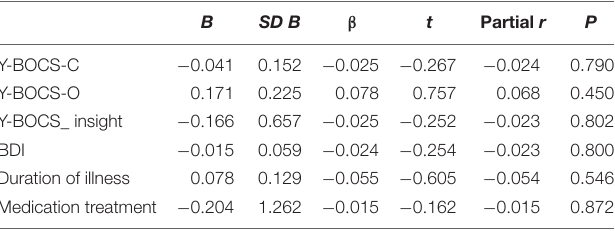
TABLE 3 | Predictors of anticipatory pleasure in patient with OCD.